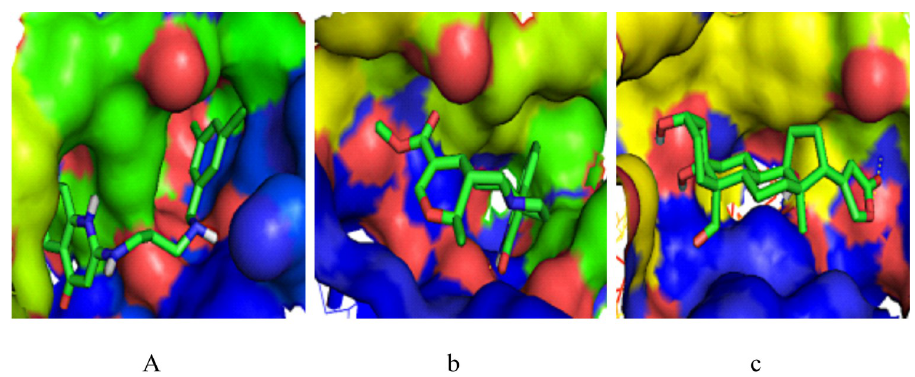
Fig 5. Binding site of the target showing interaction with reference and lead compounds. (a) BrMelMetRS-OOU complex, (b) BrMelMetRS-Isopteropodin complex (c) BrMelMetRS-Strophanthidin complex.